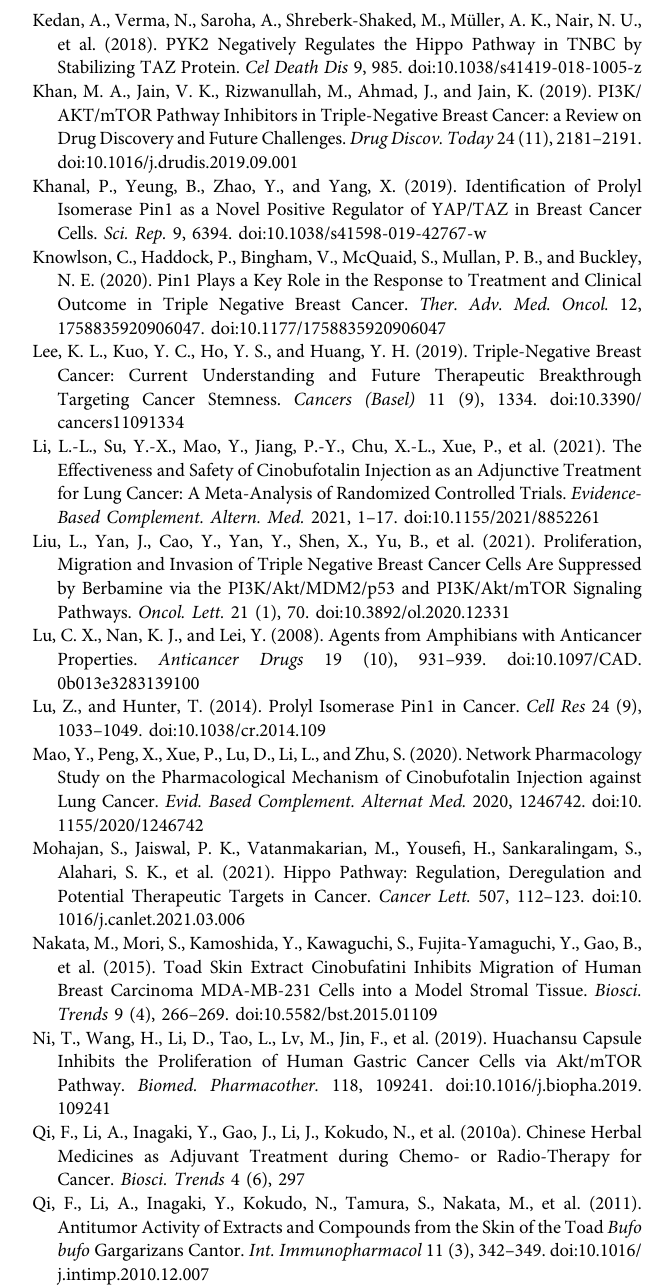
Supplementary Figure S2 | Levels of expression of PI3K, AKT, and p-Akt were determined using the Western blot assessment. Supplementary Figure S3 | Transfection of Pin1 siRNA reduces Pin1 and TAZ protein levels. (A) Levels of expression of Pin1 and TAZ in MDA-MB-231 cells were determined using the Western blot assessment after transfection of Pin1 siRNA. (B) Levels of expression of Pin1 and TAZ in HCC 1937 cells were determined using the Western blot assessment after transfection of Pin1